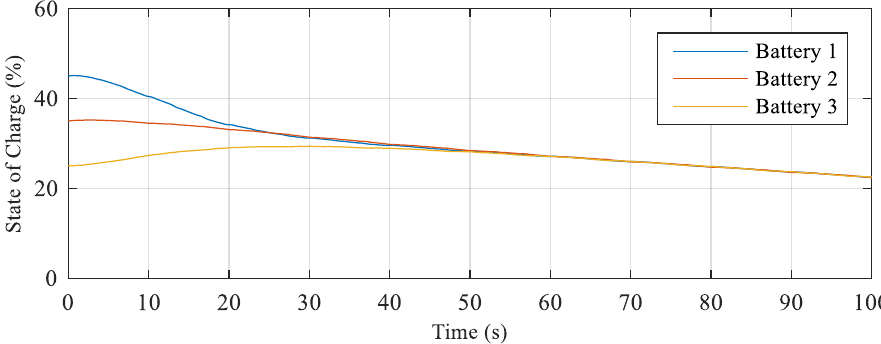
Figure 8. State of charge of batteries in the WECS with proposed controller (Case 1).